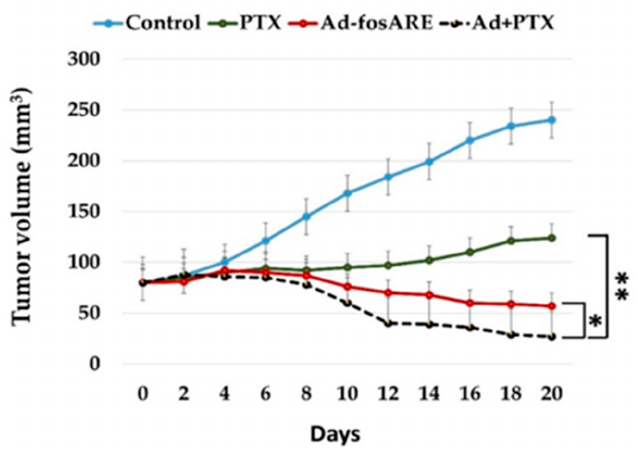
Figure 8. In vivo tumor lysis potential of the Ad- fos ARE and PTX combination therapy in human cervical cancer xenograft nude mice. HeLa S3 cells were injected subcutaneously into the flanks of female BALB/C nude mice and allowed to grow to ~56 mm in diameter. PTX (0.4 mg in 100 µL of PBS) or vehicle (cremophor EL/dehydrated ethanol/saline) was given by intraperitoneal (i.p.) injection. 1 × 10 6 ifu (100 µL) of Ad- fos ARE or the same volume of PBS was injected intratumorally (i.t.) thrice (days 1, 4, and 7) directly into the tumors after PTX injection. Tumor volumes were calculated by the following equation: Volume (mm 3 ) = A × B 2 × 0.5 (A is considered the longest diameter; B is considered shortest diameter). * indicates p < 0.05, ** indicate p <